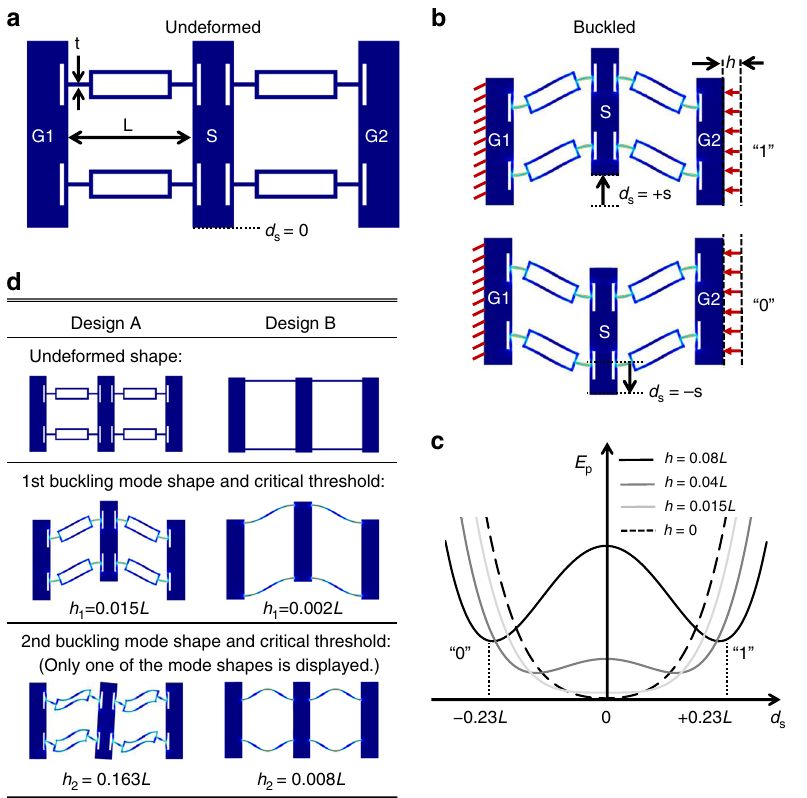
Fig. 1 Design of bi-stable fl exure mechanisms. a Undeformed shape of a bi-stable fl exure mechanism with a smallest feature size t = L /30, where L is the length of a bi-stable fl exure. b Two buckled shapes of the bi-stable fl exure mechanism that are generated using COMSOL Multiphysics ® where high-stress regions are indicated by bright colors. c Total deformation energy E p as a function of the position d s and compression distance h for the bi-stable fl exure mechanism in b . d Undeformed shape, fi rst, and second buckling mode shapes and their corresponding critical compression distance h 1 and h 2 of two different bi-stable fl exure mechanism designs. Design A was chosen for this study due to the large distance between 1 st and 2 nd buckling modes which means the logic gate is more tolerant to errors in the fi xturing during